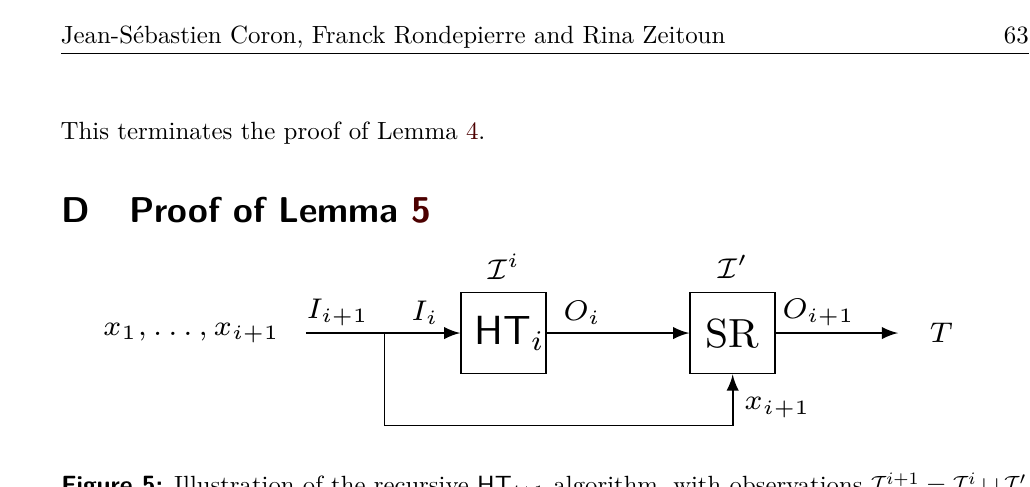
Figure 5: Illustration of the recursive HT i +1 algorithm, with observations I i +1 = I i ∪ I 0